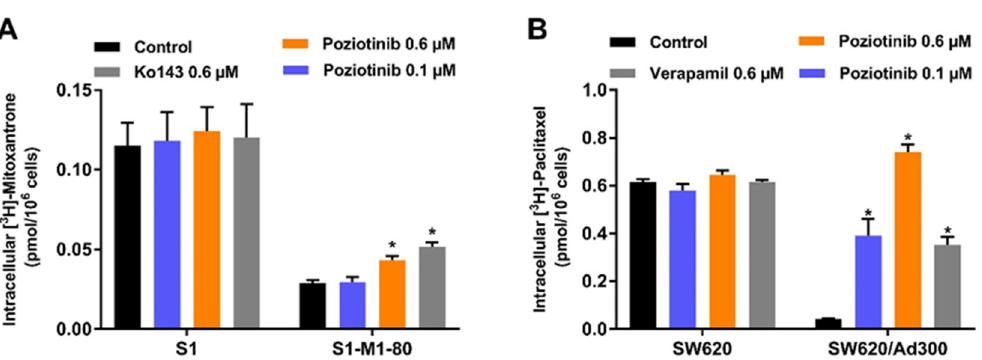
Figure 6. Poziotinib increases the accumulation of substrate drugs in MDR cells. ( A ) The effect of poziotinib on the intracellular accumulation of [ 3 H]-mitoxantrone in S1 and S1-M1-80 colon cancer cells after 2 h of incubation with [ 3 H]-mitoxantrone ( B ) The effect of poziotinib on the intracellular accumulation of [ 3 H]-paclitaxel in SW620 and SW620 / Ad300 colon cancer cells after 2 h of incubation with [ 3 H]-paclitaxel. Ko143 and verapamil were used as positive controls (i.e., inhibitors) of the ABCG2 and ABCB1 transporters, respectively. Data are expressed as the mean ± SD based on three independent experiments. * p < 0.05 versus the control group.